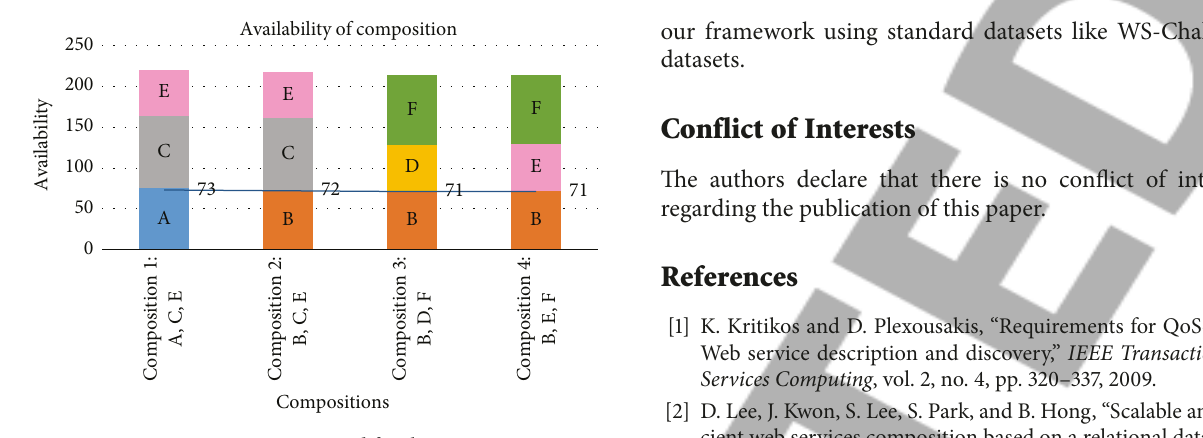
Figure 10: Composition generated for the service request. Table 8: Generated composition